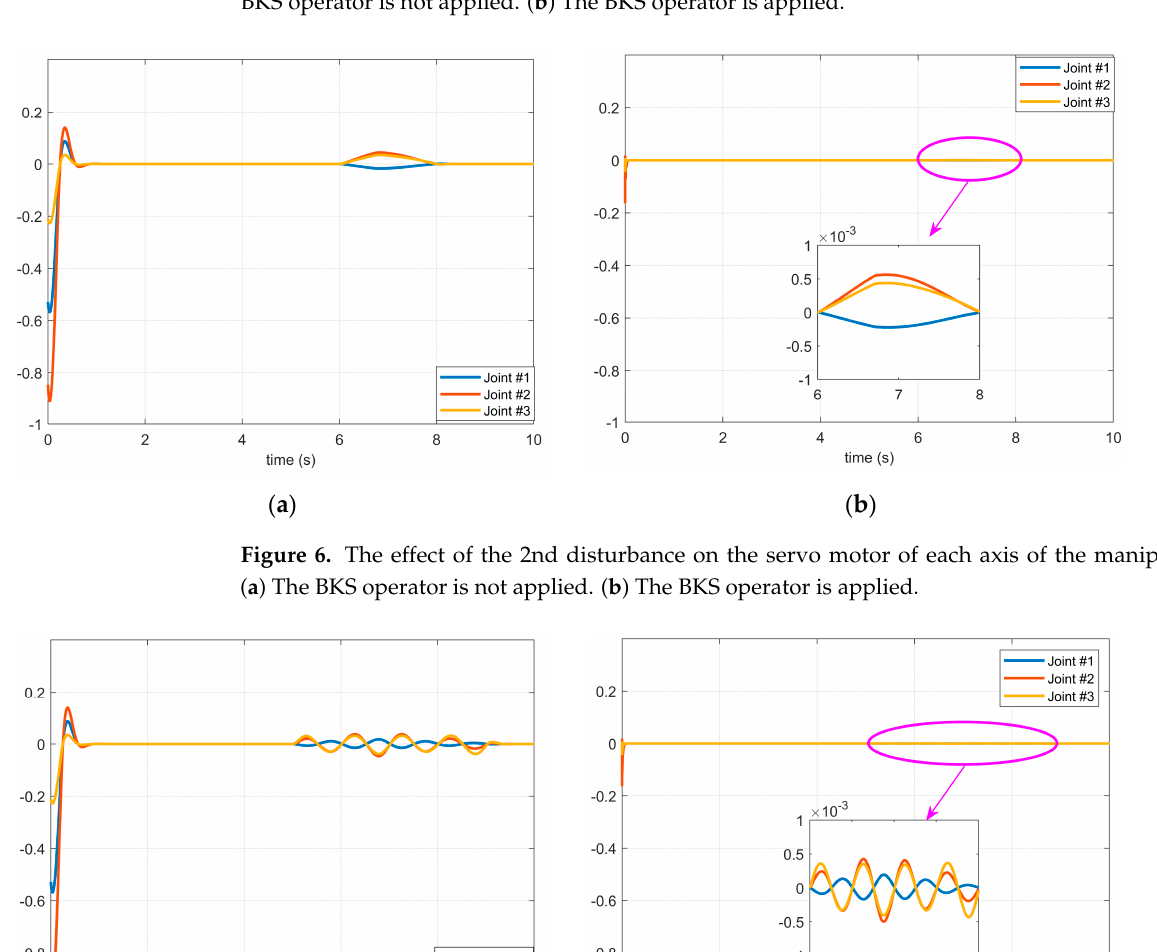
Figure 5. The effect of the 1st disturbance on the servo motor of each axis of the manipu- lator: ( a ) The BKS operator is not applied. ( b ) The BKS operator is applied.